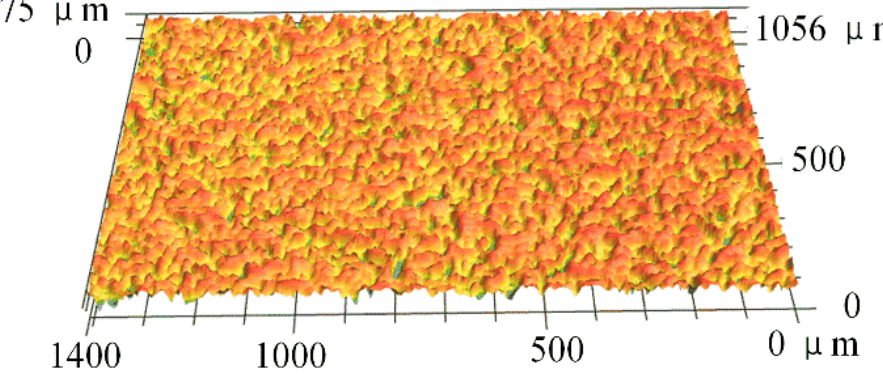
Figure 1. SPCC surface morphology.